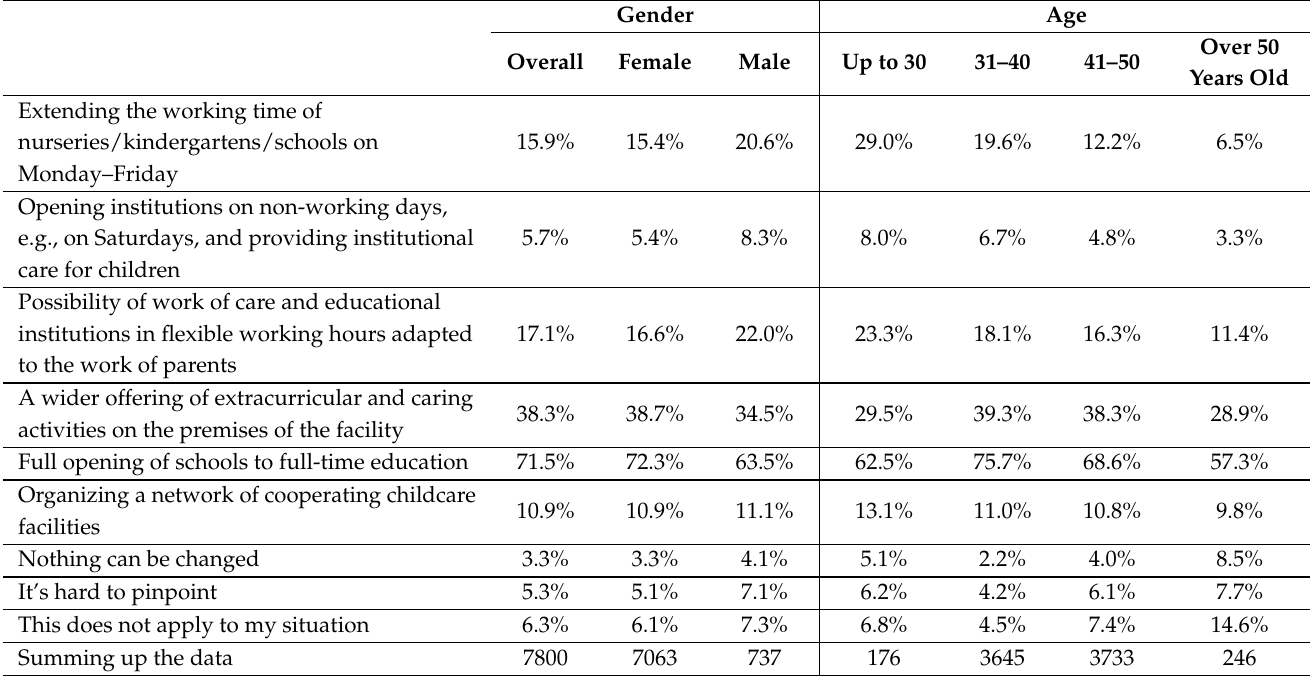
Table 2. Solutions by the education system that could help in reconciling work and private life during the pandemic (gender and age) (n =